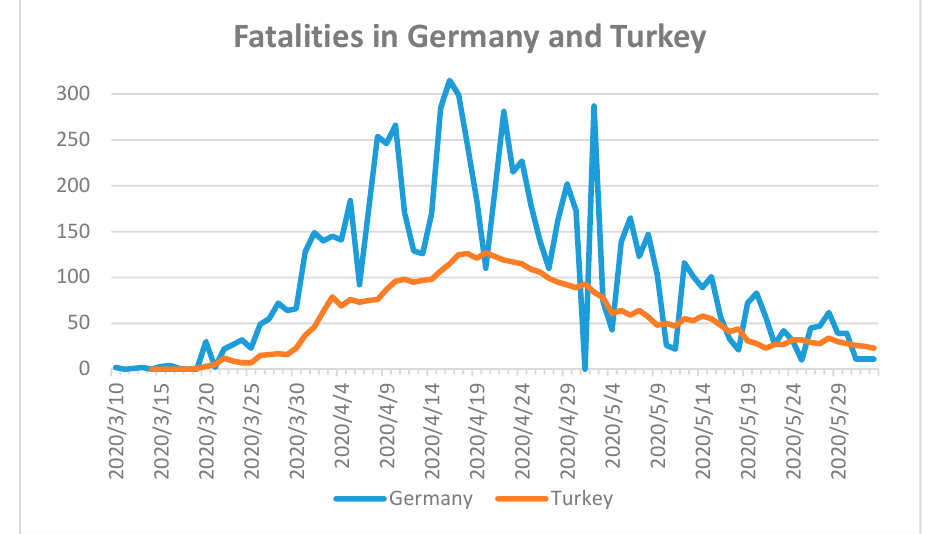
Figure 3. Fatalities during COVID-19 in Germany and Turkey until 2 June 2020 [18]. First fatality in